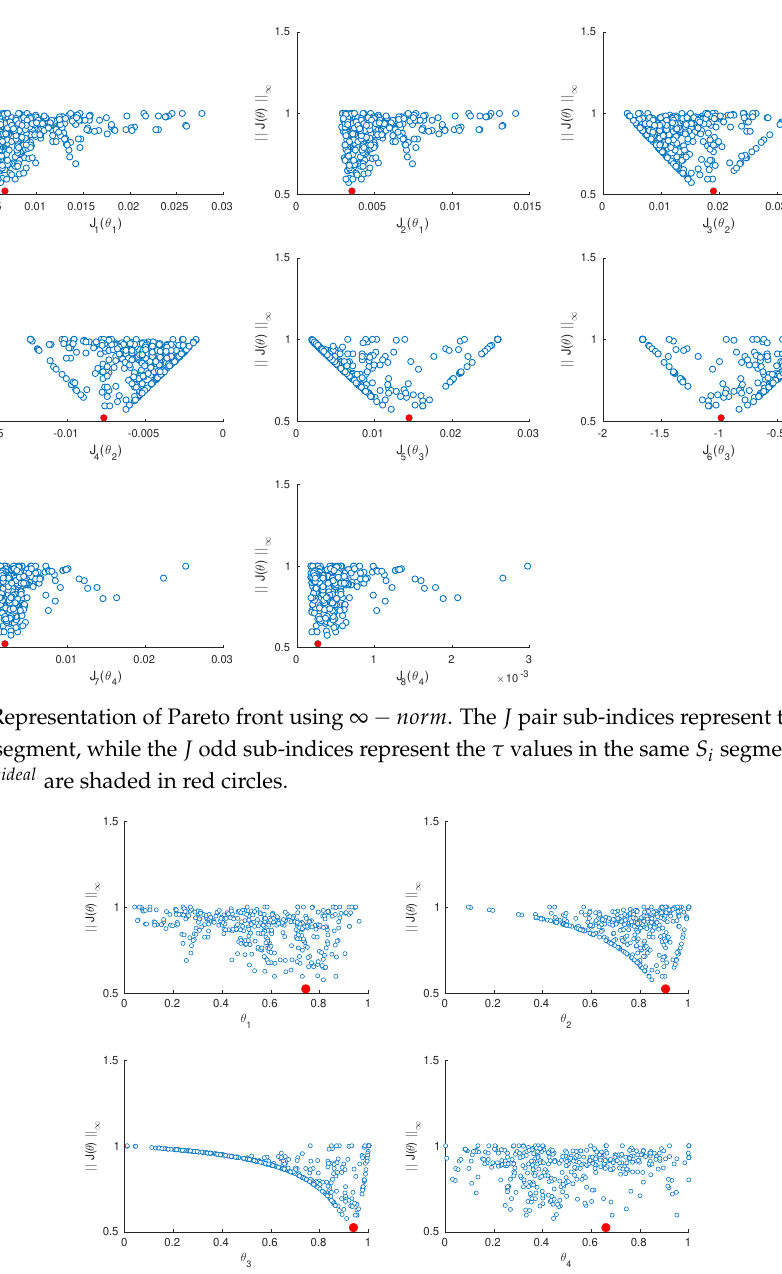
Figure 7. Representation of Pareto’s optimal parameters. Targets closest to J ideal are shaded in red